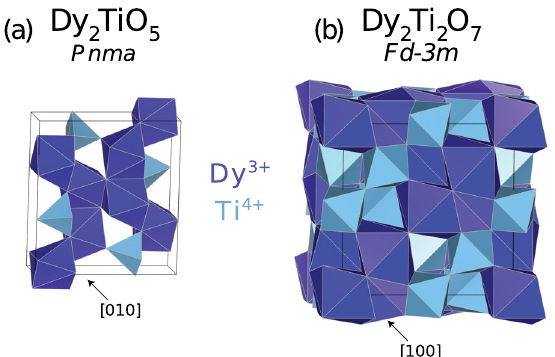
Fig. 1 3-D polyhedral renderings of the Dy 2 TiO 5 and Dy 2 Ti 2 O 7 starting structures. Titanium polyhedra represented by a lighter blue, and dysprosium polyhedra represented by a darker blue for a the orthorhombic, Pnma structure (Dy 2 TiO 5 ) and b the cubic, Fd-3m pyrochlore structure (Dy 2 Ti 2 O 7 ).